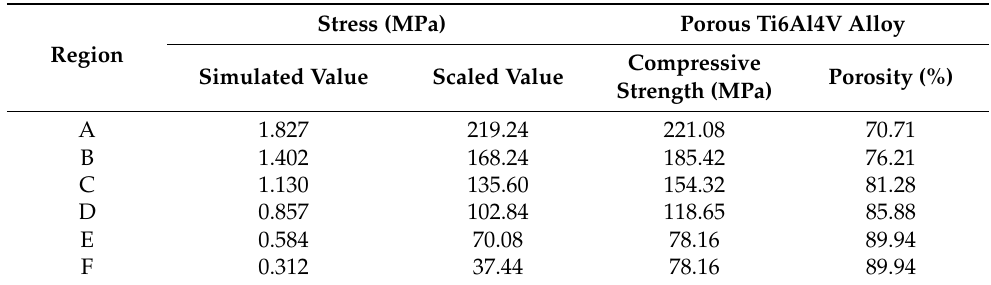
Table 5. Stress values in regions A–F and compressive strength and porosity of Ti6Al4V alloy.